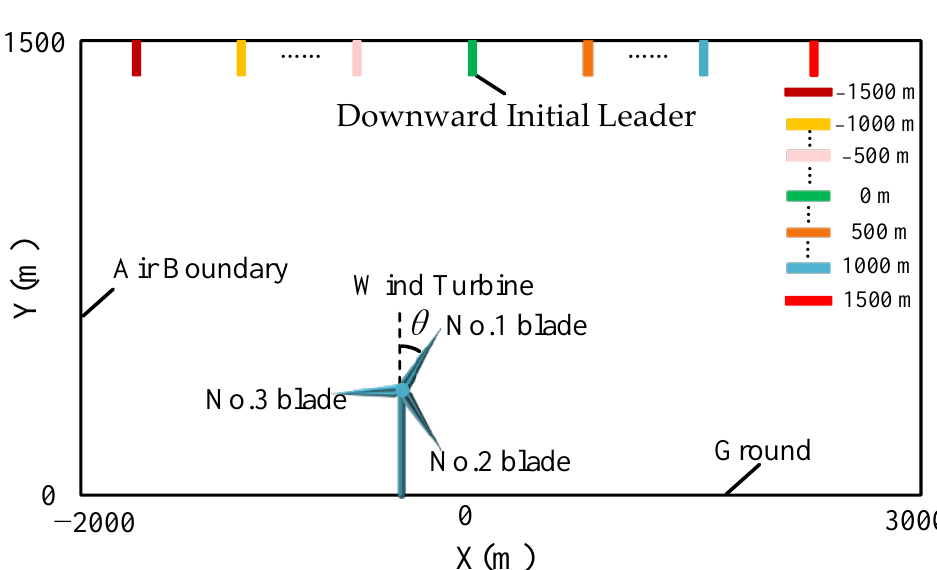
Figure 3 is a schematic diagram of the simulation area. Previous research results indicated that the blade is relatively still during the attachment process [25]. To simplify the description below, the blade in the first quadrant is named as No. 1 blade, the other two as No. 2 and No. 3 blade in the clockwise direction, respectively. The wind turbines are conducted under three basic states according to the rotation angle of the No. 1 blade, which are 0 ◦ , 30 ◦ and 60 ◦ , as shown in Figure 3. The blade angle θ is the angle between the No.1 blade and the vertical direction with the clockwise direction being positive. The wind turbine is fixed on the site of the abscissa of 0 with diverse heights, and rectangles in various colors represent different initial positions of downward leader. The abscissa of the downward leader initial position is regarded as the lateral distance which ranges from − 1500 m to 1500 m (The negative value indicates that the initial position of the downward leader is on the left of the wind turbine, and the positive value indicates that it is on the right, also with an interval of 100 m).